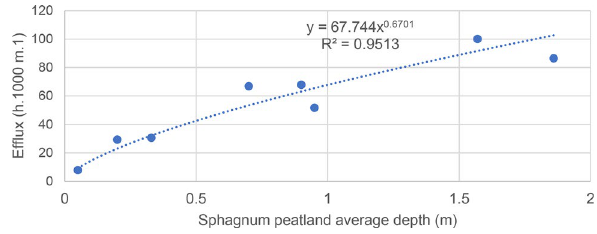
Fig. 8 Relation between Sphagnum peatland’s depth and water efflux. Peat depth obtained by GPR and modulated in GIS. Time efflux values obtained in the lab as described by Pereira (2015)